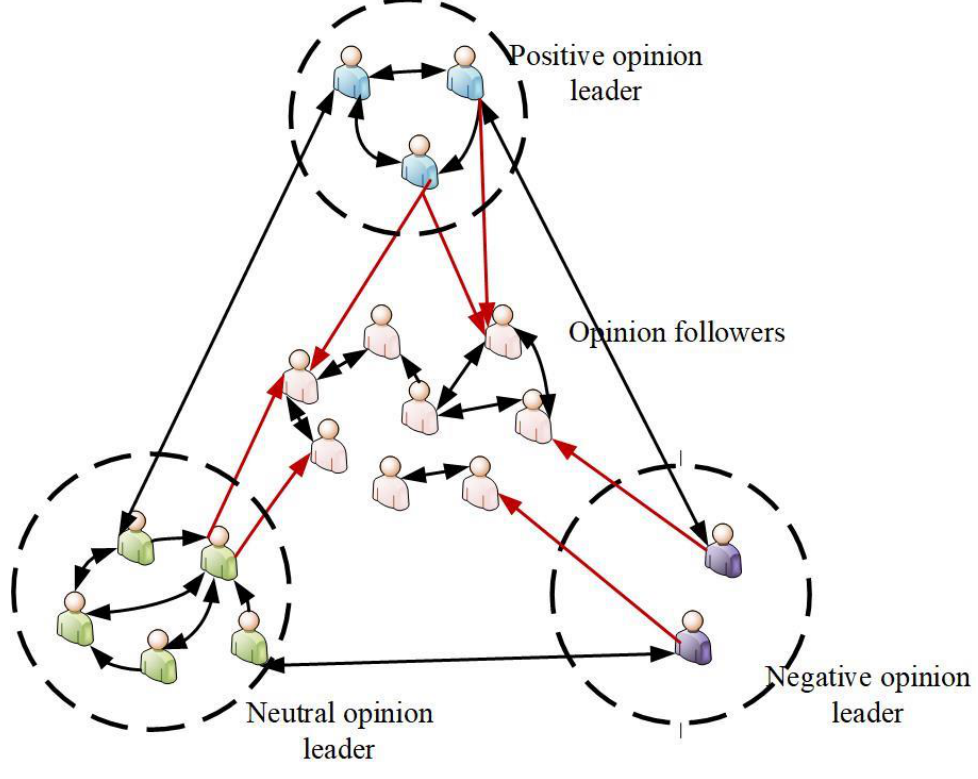
Figure 5. Interaction of all online individuals’ opinion about the